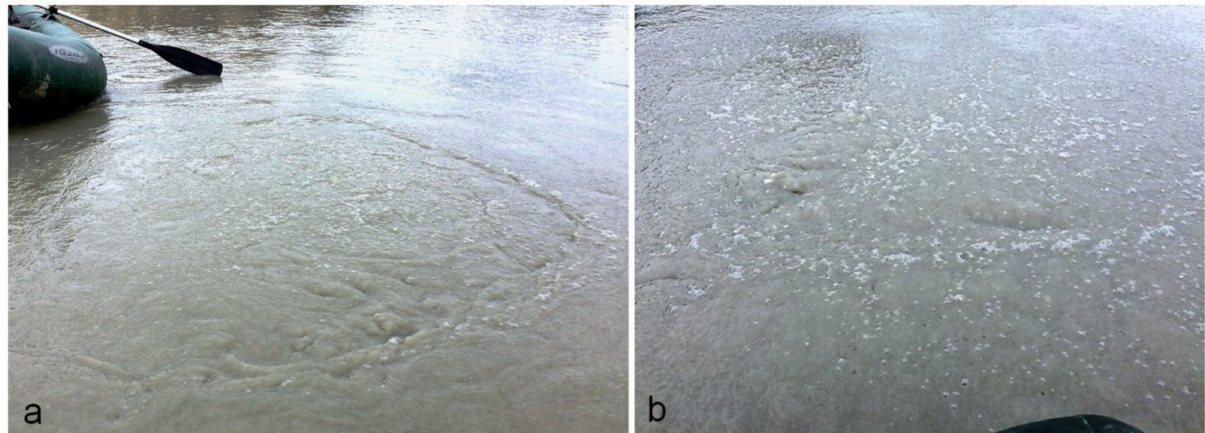
Figure 4. Zone of strong gas emission in the flooded crater ( a ) and enlarged fragment of the central zone of gas release ( b ), 2 July 2017 (location—see Figure 5A) (photos by Vasily